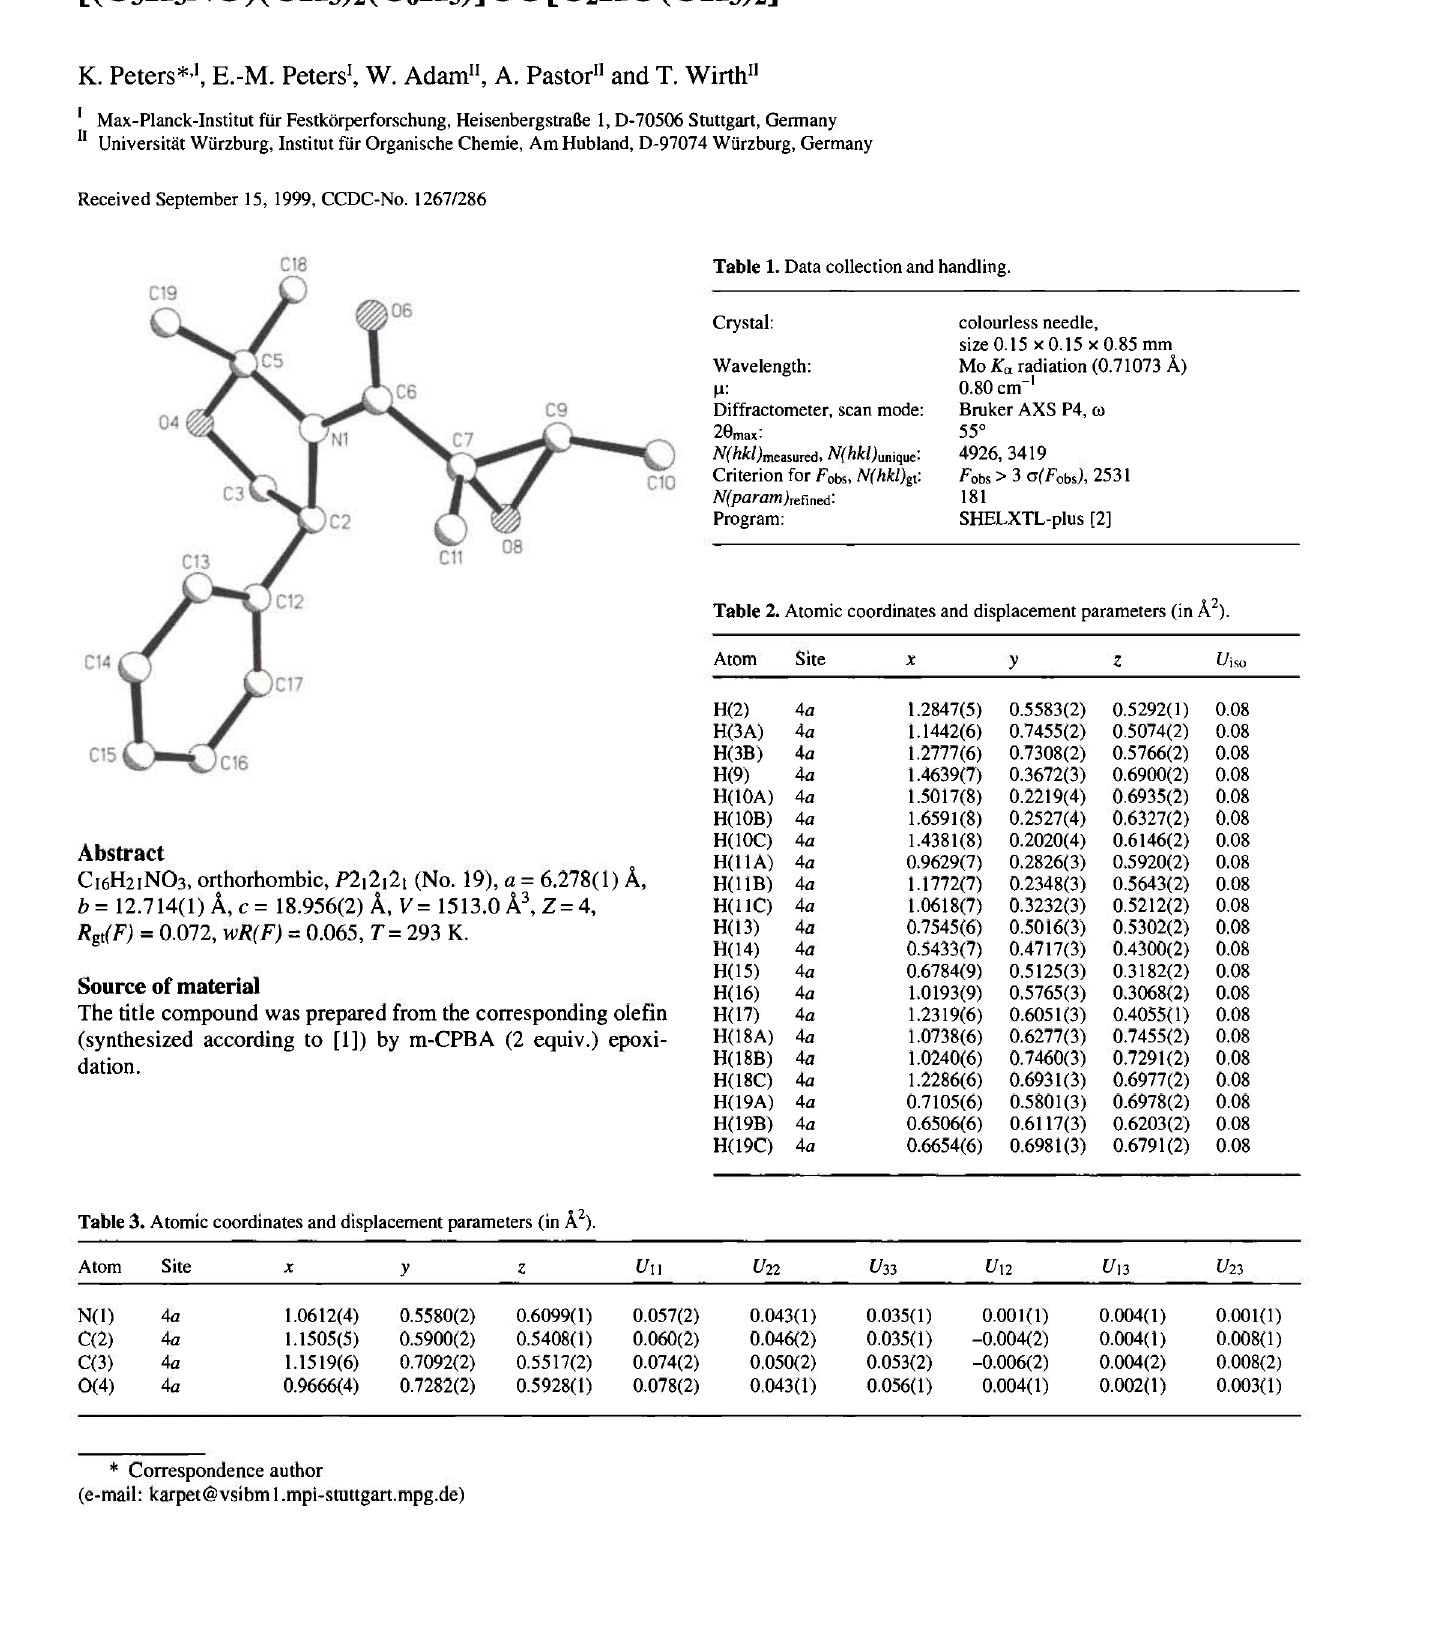
Table 1. Data collection and handling.